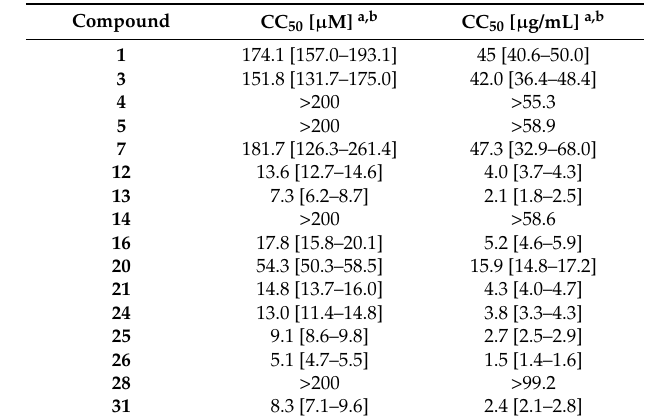
Table 2. Cytotoxicity of selected chalcone-based analogues against Vero cells (CC 50 values are expressed in µ M and µ